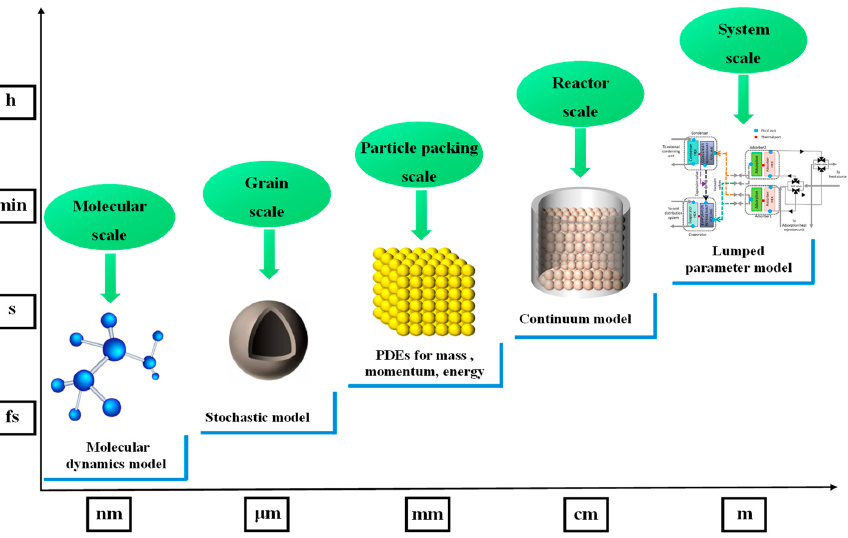
Figure 6. Thermochemical energy storage systems involve a large-length scale, requiring a multiscale approach.